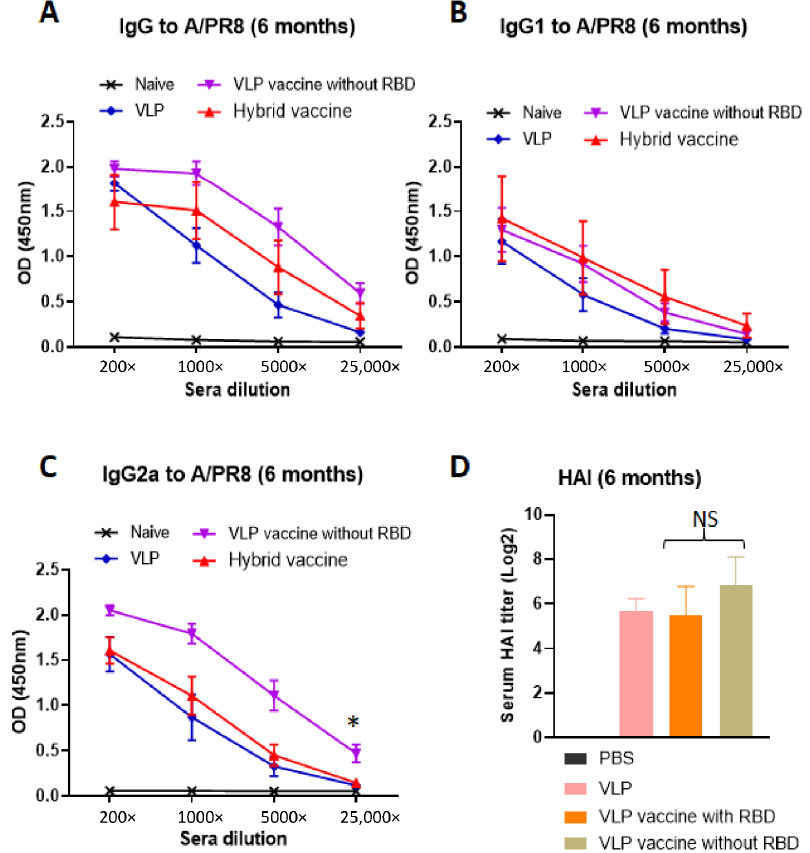
Figure 4. Hybrid vaccine induces influenza A/PR8 virus-specific antibody response. ( A – C ) ELISA plates were coated with inactivated influenza A/PR8 H1N1. Serum samples from mice vaccinated with VLP, VLP with GPI-GM-CSF and GPI-IL-12 or hybrid vaccine were serially diluted (5-fold) and added to the wells after blocking the plates. ( D ) Hemagglutination inhibition (HAI) titer in the sera of mice. Isotype specific anti-mouse Ig-HRP conjugate was used to detect the isotype of the antibody bound. * p <